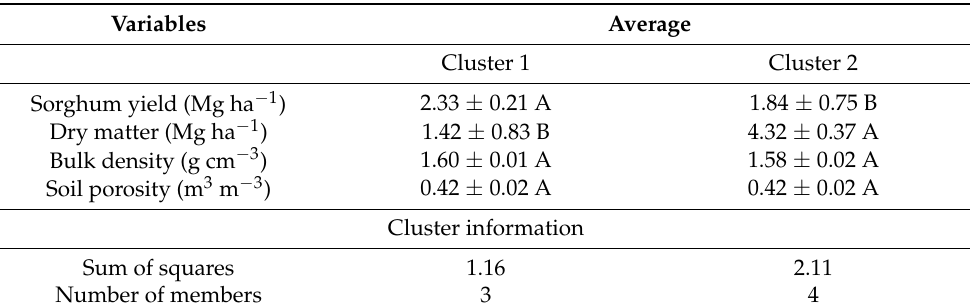
Table 5. Averages of sorghum yield, grass dry matter, bulk density, and soil porosity within clusters (Clusters 1 and 2) in the systems with sorghum and